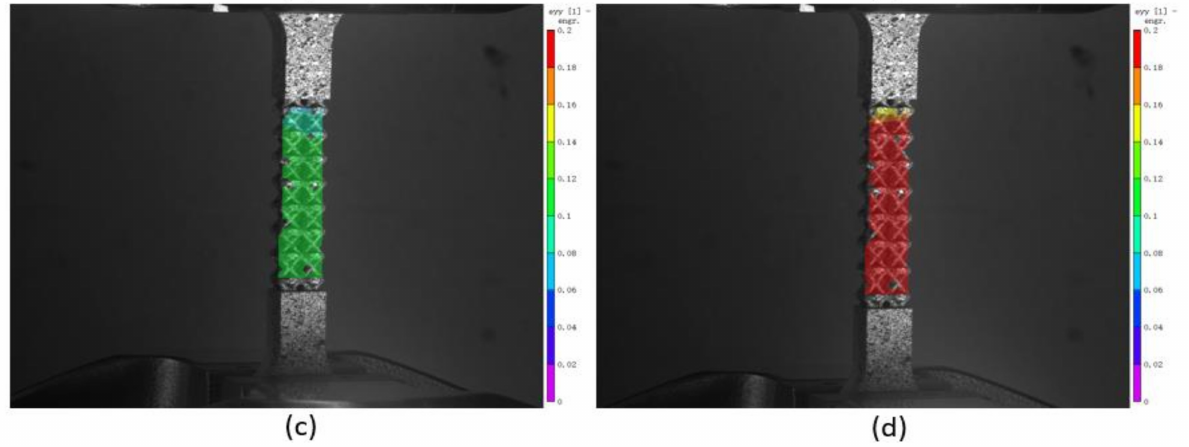
Figure 12. DIC frames of the four points marked out in the tension 316L stainless steel dog-bone lattice curve: ( a ) 6 s; ( b ) 18 s; ( c ) 150 s; ( d ) 295 s.